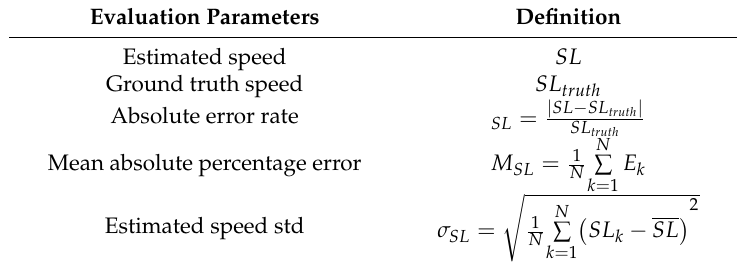
Table 6. Evaluation parameters definition.